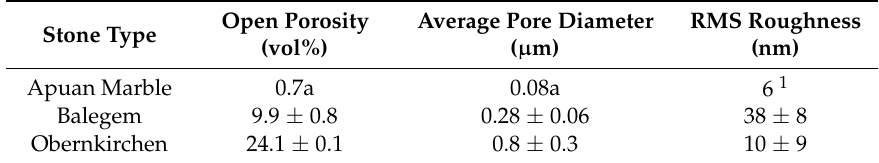
Table 1. Open porosity, average pore diameter and surface roughness (Root Mean Square (RMS)) of the three lithotypes.